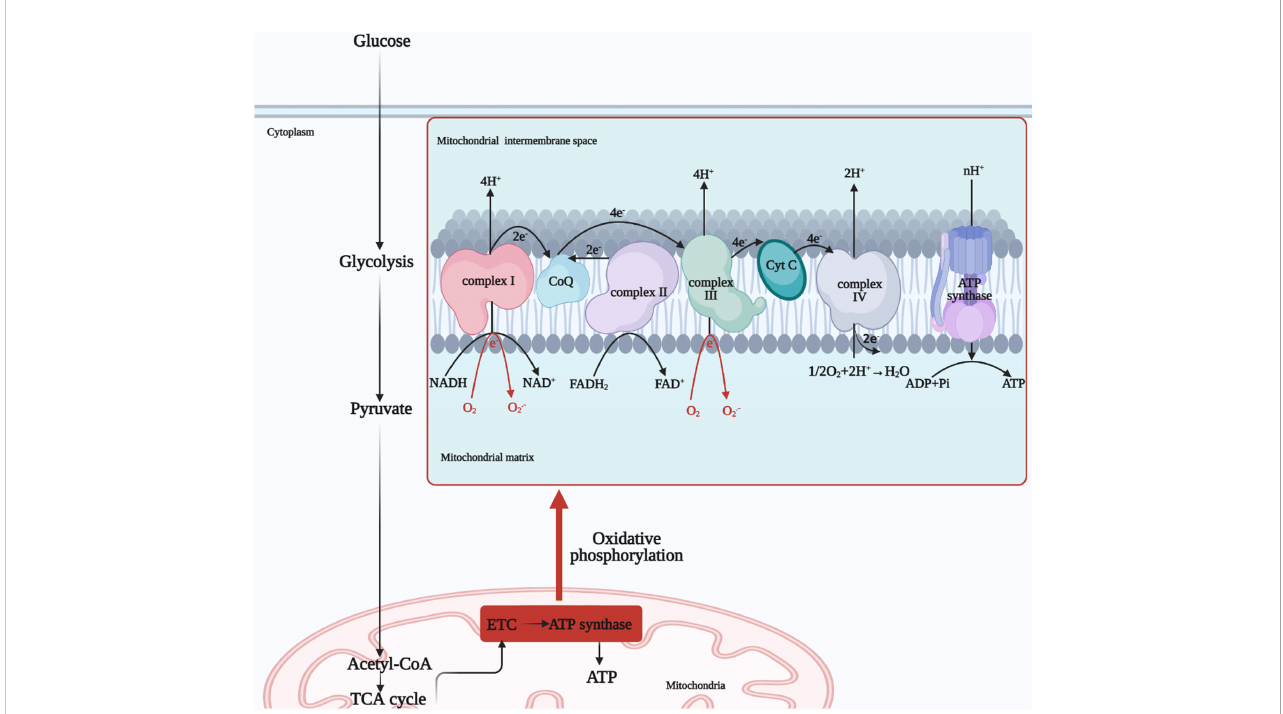
FIGURE 2 Mitochondrial OXPHOS process. Glucose undergoes glycolysis to produce pyruvate, which is oxidized to acetyl-coenzyme A or carboxylated to produce oxaloacetate, which enters the mitochondrial matrix for the TCA cycle. And fi nally NADH and FADH 2 , electron donors, undergo electron transfer by the ETC to produce H 2 O from O 2 and ATP by the action of ATP synthase, completing OXPHOS process. NADH, nicotinamide adenine dinucleotide; FADH 2 , fl avin adenine dinucleotide; ETC, electron transfer chain; TCA, tricarboxylic acid; ATP, adenosine triphosphate, ADP, adenosine diphosphate; OXPHOS, oxidative phosphorylation; Cyt C, cytochrome c; O 2.- , superoxide